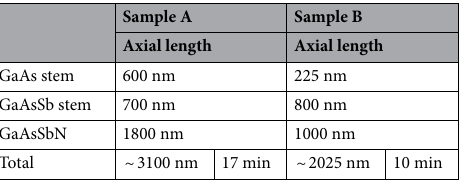
Table 1. Summary of the growth duration and approximate axial segment length for samples A and